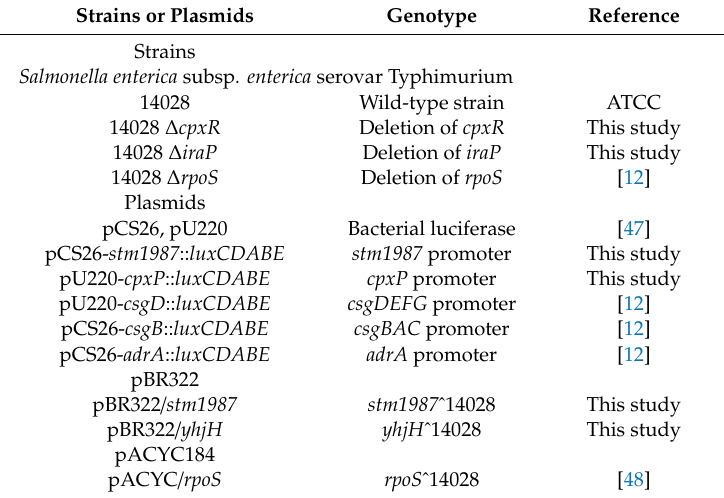
Table 1. Strains and plasmids used in this